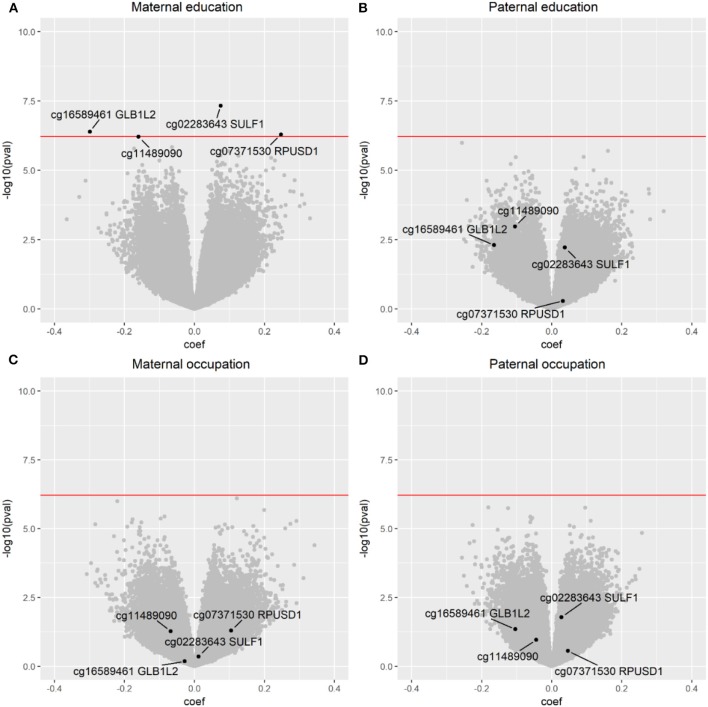
Results from the methylome-wide association study relating cord blood DNA methylation profiles and maternal and paternal education or occupation. (A) Maternal education, (B) Paternal education, (C) Maternal occupation, (D) Paternal occupation. Results are derived from the ALSPAC cohort (40). In the “volcano plot” the x axis is related to a measure of the strength of the signal (i.e., association with SEP in this case), and the y axis is related to the statistical significance of the signal. CpGs above the red line are statistically significant after correction for multiple comparisons.